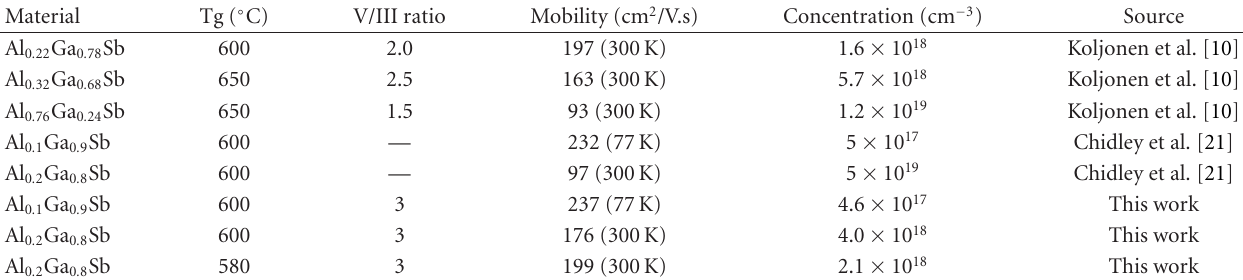
Figure 2: Surface morphology of Al x Ga 1 − x Sb epilayers grown on GaAs with a di ff erent Alcontent grown at 580 ◦ C and 600 ◦ C with a V/III ratio of 3. Table 1: Hole mobility and carrier concentration of Al x Ga 1 − x